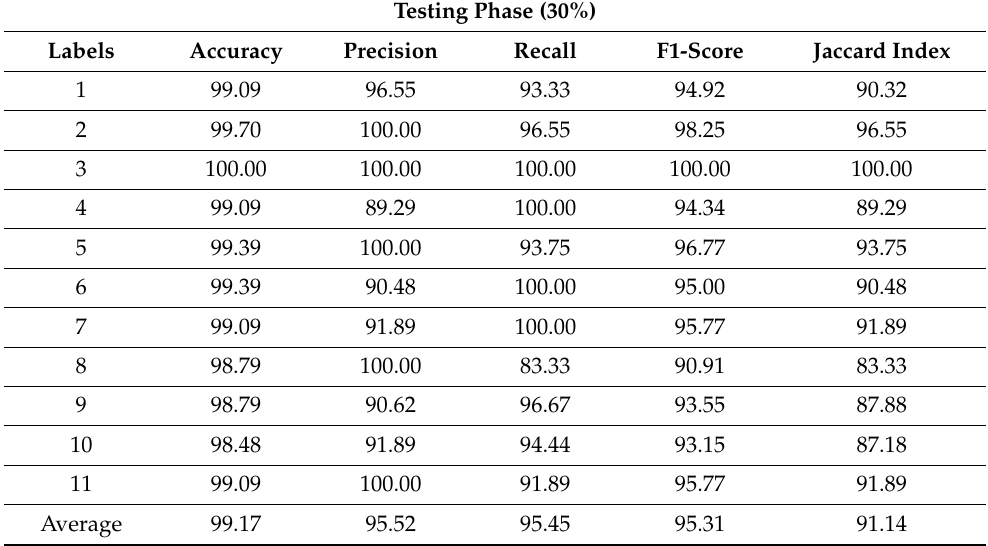
Table 4. Result analysis of ASODCAE-SLR approach with distinct class labels under 30% of TS data. Testing Phase (30%)